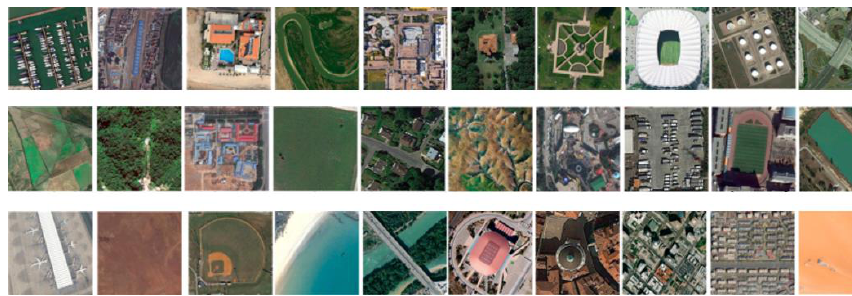
Figure 3. Sample images of AID dataset.